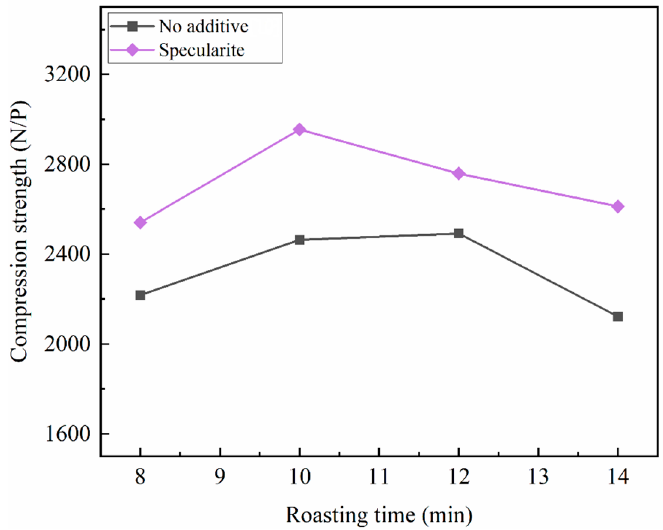
Figure 7. Effects of roasting time on compression strength of roasted pellets (preheating temperature 950 °C , preheating time 14 min, roasting temperature 1080 °C ).